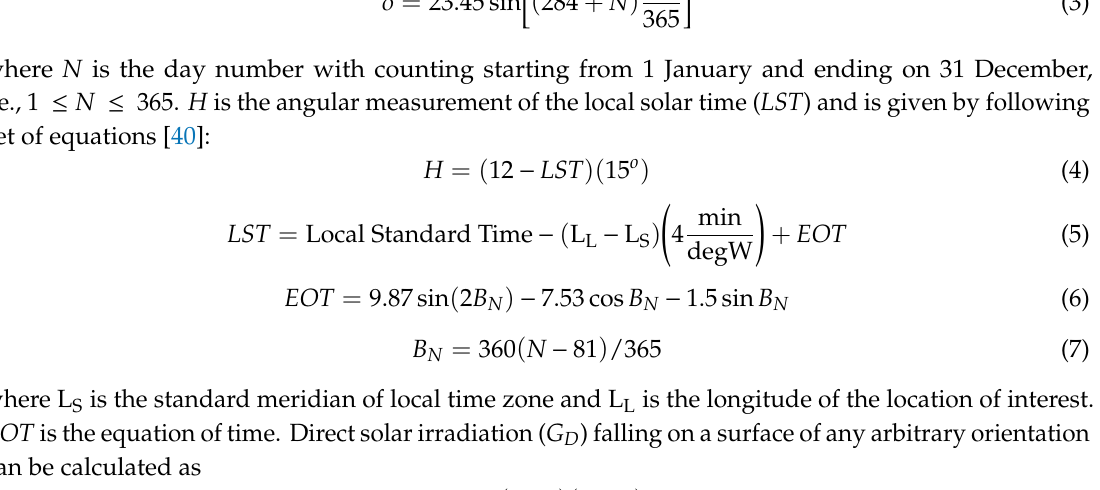
→ → → S , R and H in a Cartesian coordinate